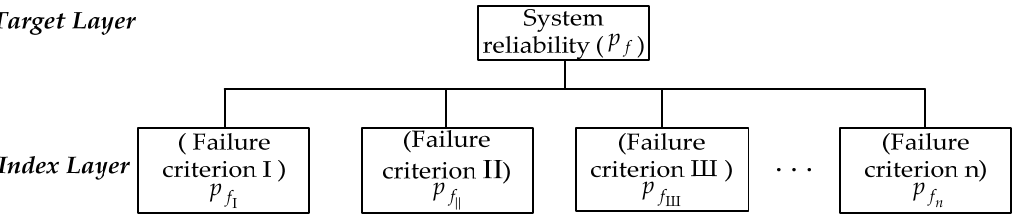
Figure 5. The hierarchical mode of system reliability evaluation.